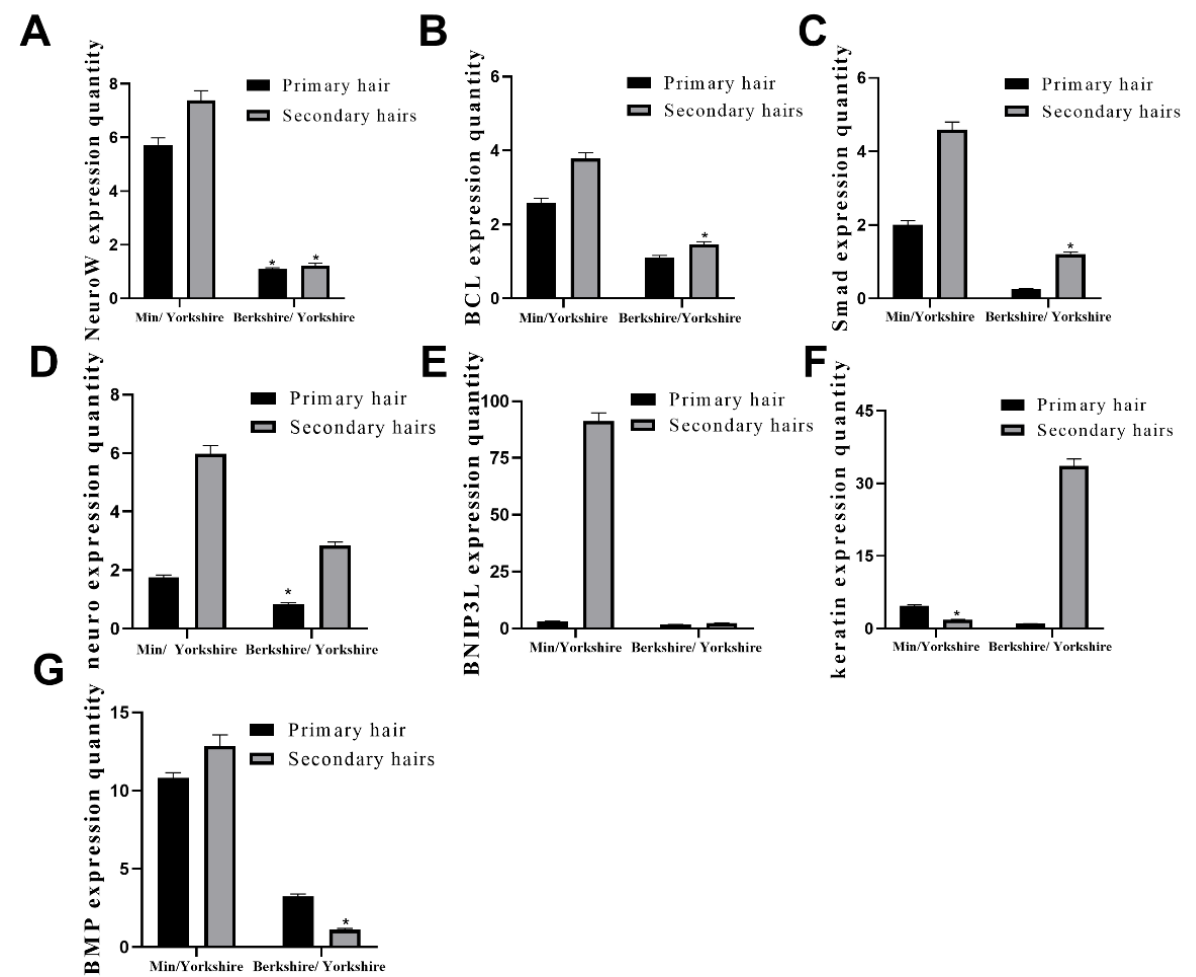
Figure 4. The 7 differentially expressed genes (NeuroW, BCL, Smad, neuro, BNIP3L, keratin, BMP) were selected for the analysis of revalidation with the qRT-PCR in the primary hair and hair follicle tissues from three breeds ( A – G ). The GAPDH was used as a reference gene to normalize q-PCR data. Bars represent the standard and error. * p < 0.05.